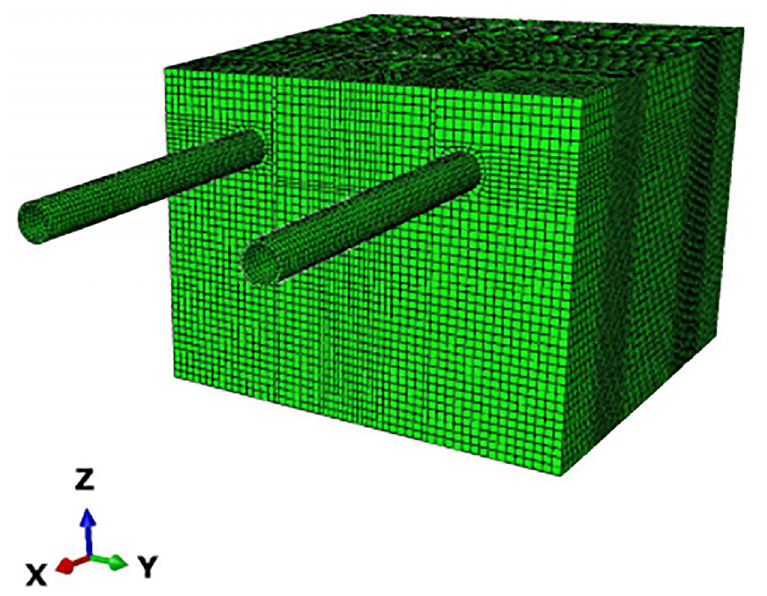
Fig 5. Overall model meshing results.